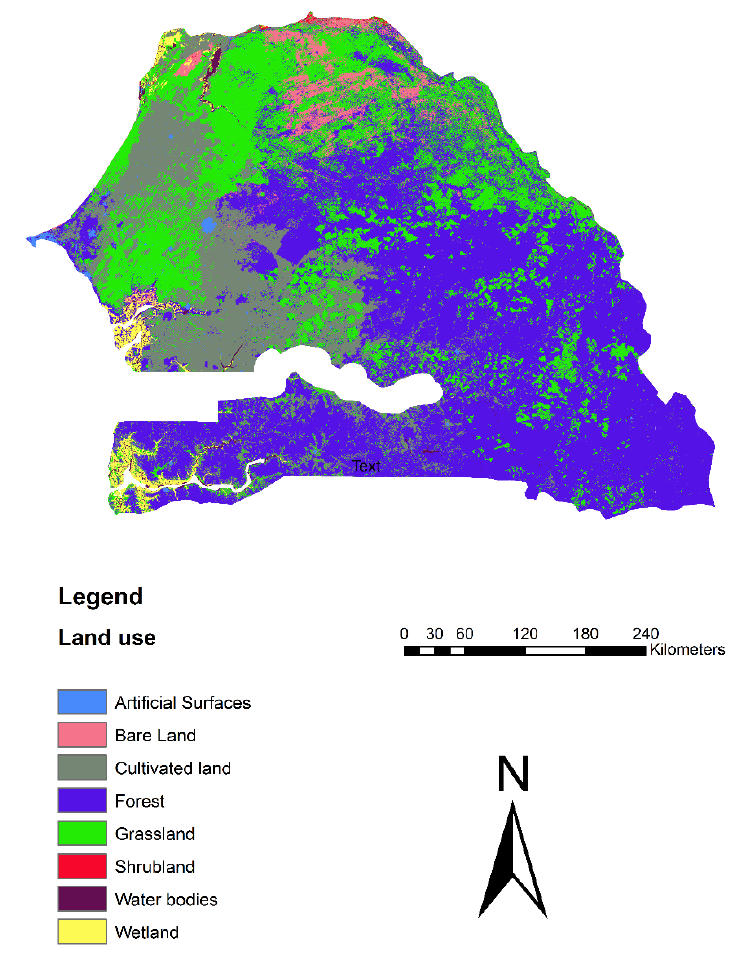
Figure 3. Land-use map of Senegal at 30-meter resolution .